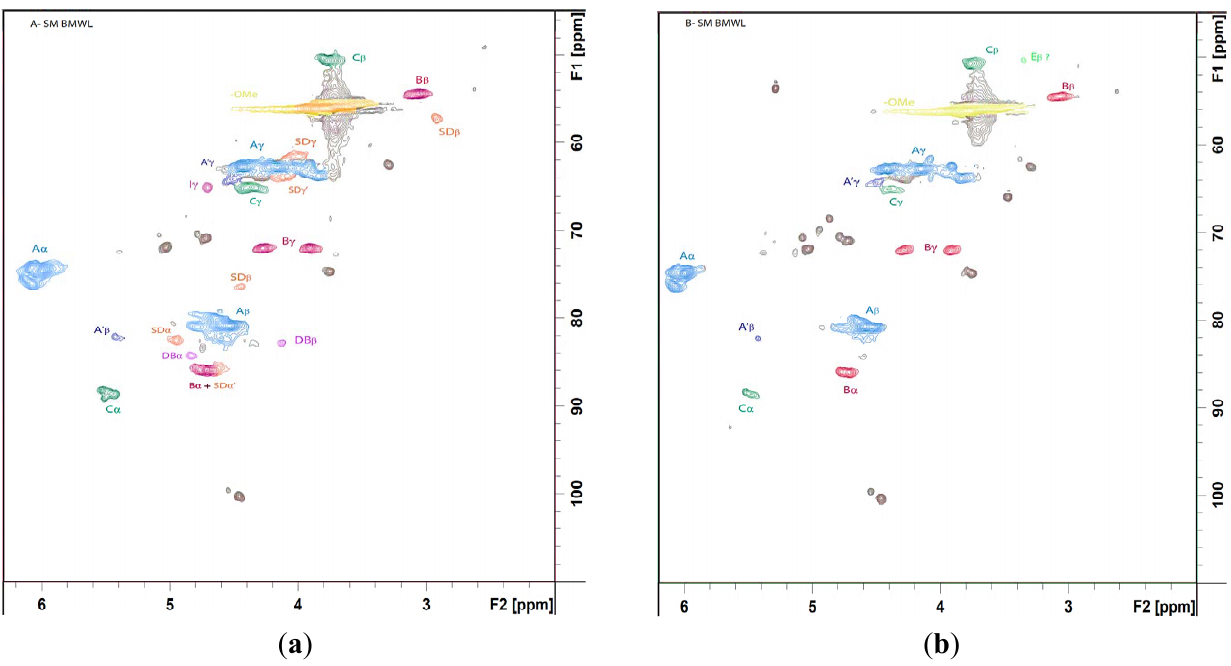
) of ball-milled wood samples before and after av : coefficient of variation; and FPL: the Forest V